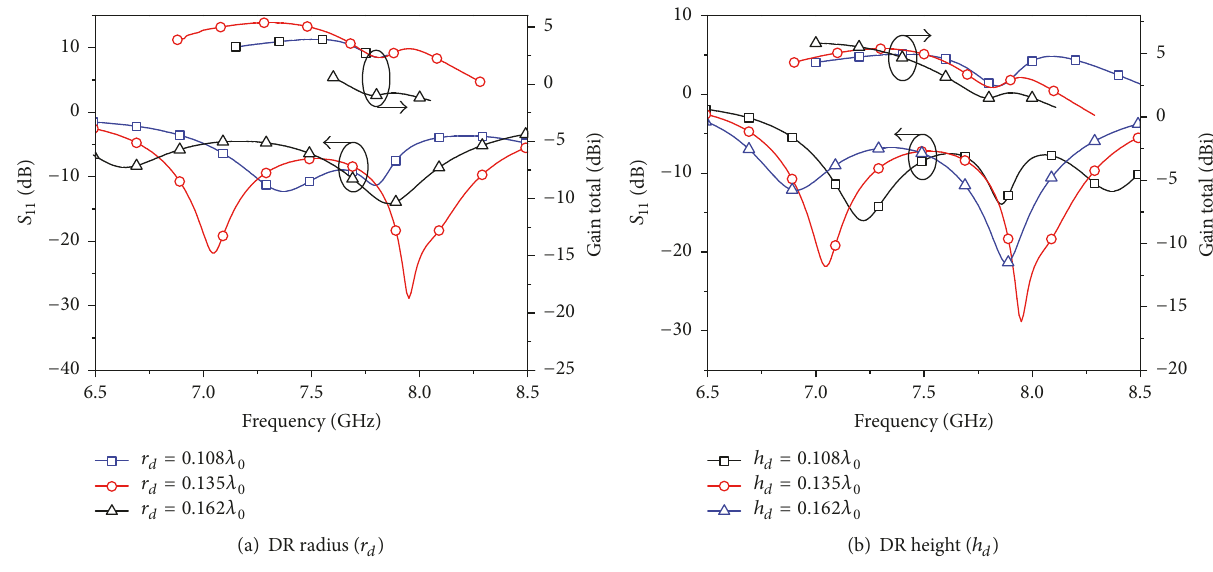
Figure 5: It illustrates S 11 versus frequency.